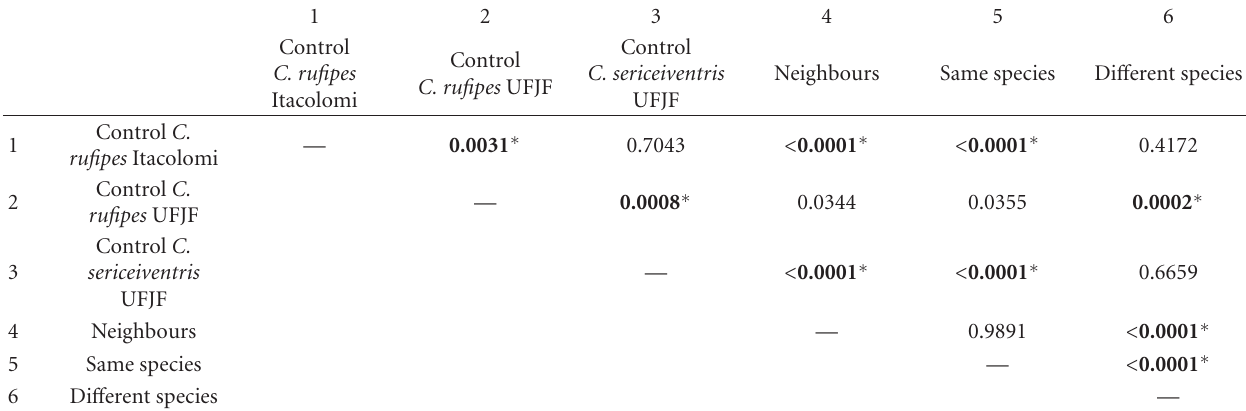
Table 2: Student-Newman-Keuls ( H = 77 . 1648) comparisions for each treatment of dyadic encounters listed in Table 1 (significative P - values in